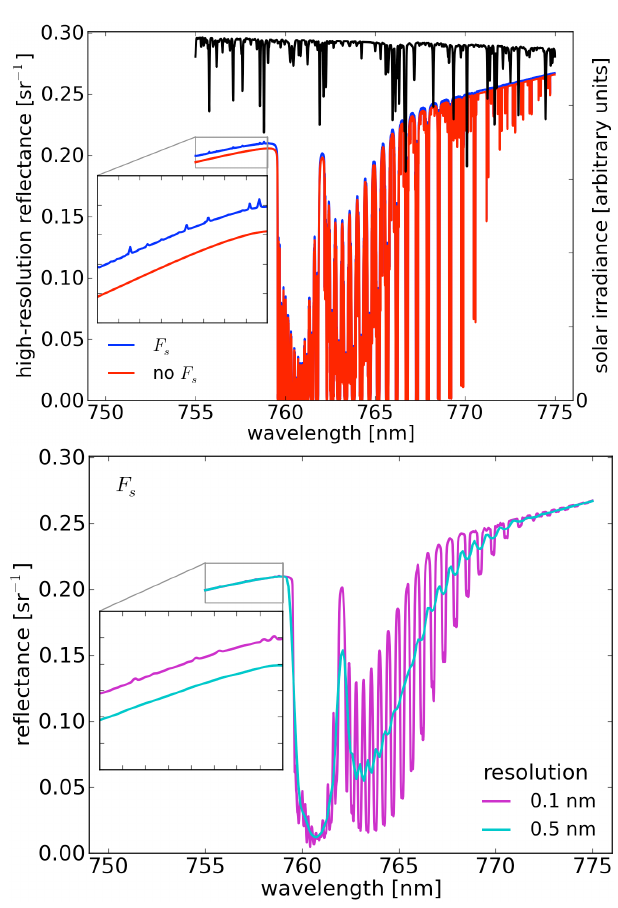
), fluorescence emission 2 s ) at a spectral resolution 3 mid ’: red line), and a high-3 s A 7 2 linearly 8 s A band occurs as 14 2